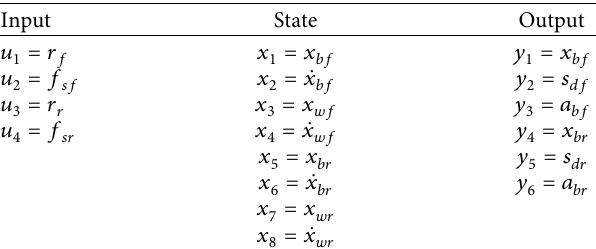
Table 1: Summary of the Input-State-Output variables for the half- car active